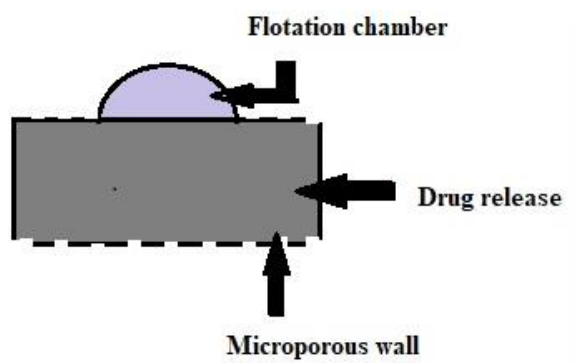
Fig. 2. Graphical representation of intra-gastric floating drug delivery